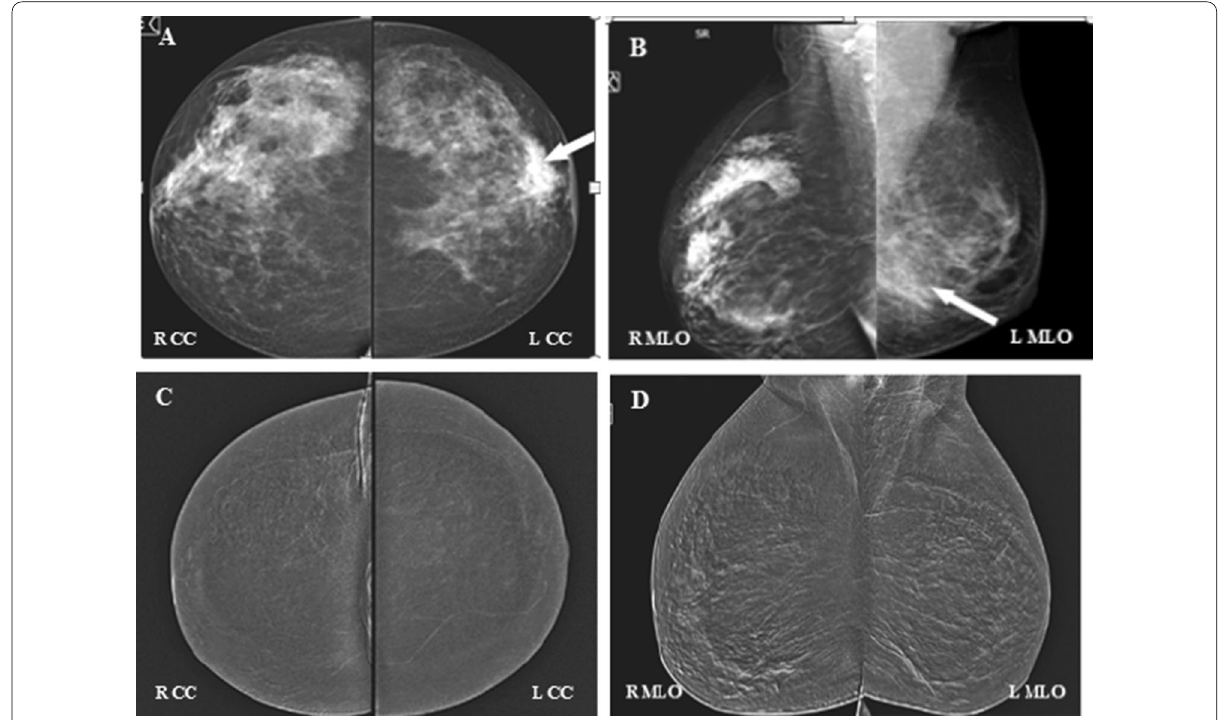
Fig. 3 A 36-year-old female performed a follow-up examination after left conservative breast surgery for breast cancer one year ago. (A) Craniocaudal mammographic view of both breasts, and (B) Mediolateral mammographic views of both breasts revealed left breast lower outer quadrant focal asymmetry (arrows) associated with skin thickening, asymmetric left breast size and densities (postoperative sequalae) . (C) Craniocaudal CEM view of both breasts, and (D) Mediolateral CEM views of both breasts revealed no enhancement; no underlying pathology. Pathology revealed normal